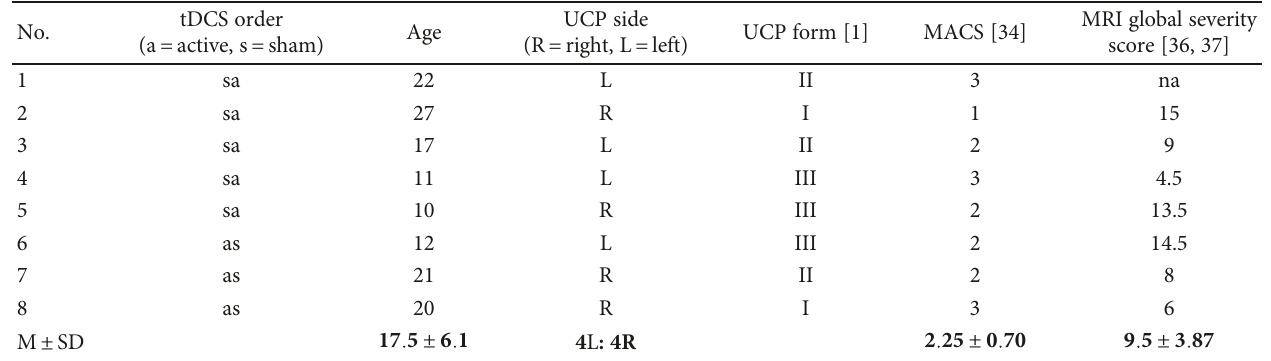
Table 1: Characteristics of the